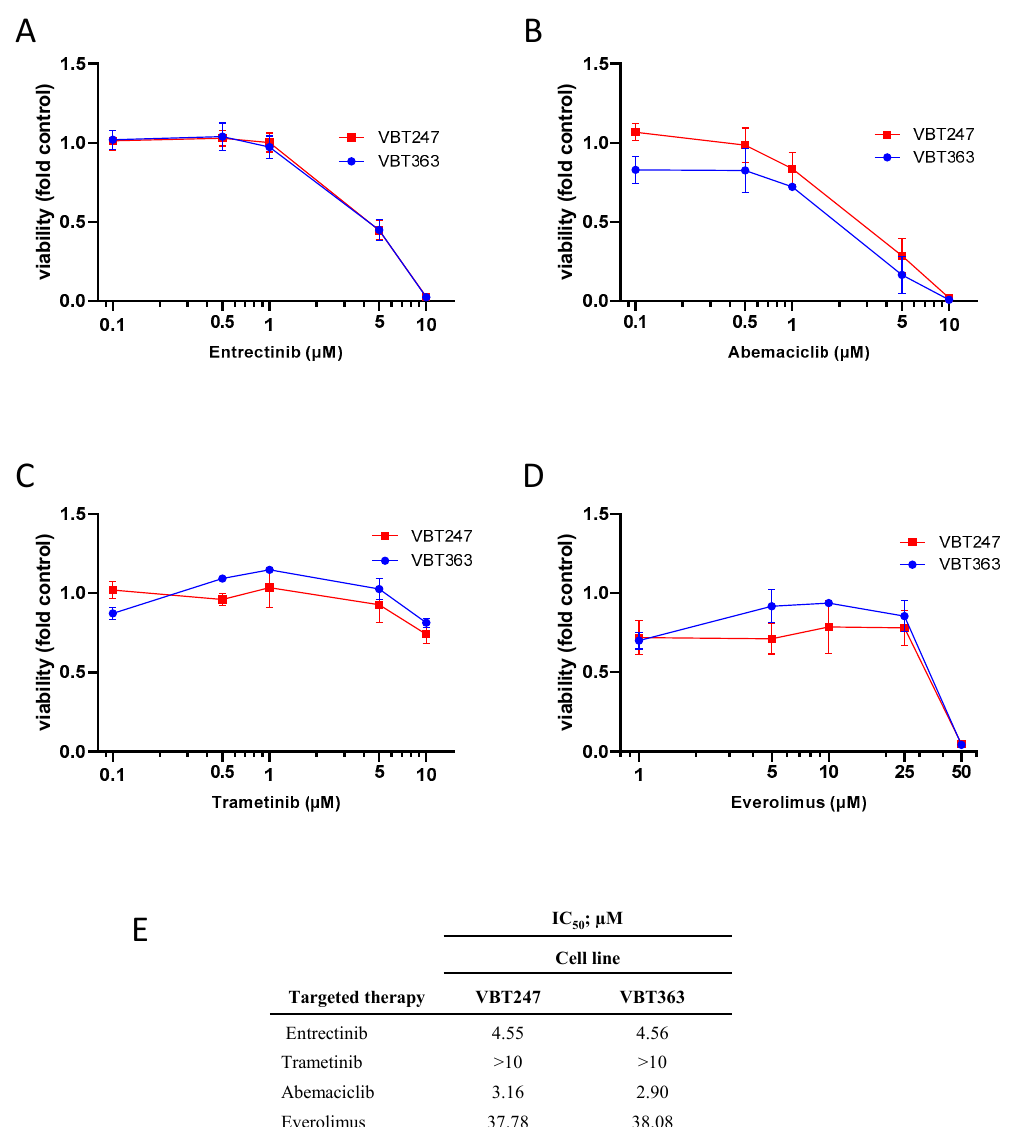
Figure 4. E ff ect of single-agent targeted therapies in EML4:NTRK3 positive cell lines. The impact on cell viability of ( A ) entrectinib, ( B ) abemaciclib, ( C ) trametinib and ( D ) everolimus on the primary tumor (VBT247) and the 3rd recurrence under treatment with entrectinib (VBT363) was tested after 72 h incubation by ATP assay in triplicates. ( E ). The inhibitory e ff ect is expressed as IC 50 values calculated from full dose–response curves (drug concentrations inducing a 50% reduction of the cell number in comparison to the untreated control cells).